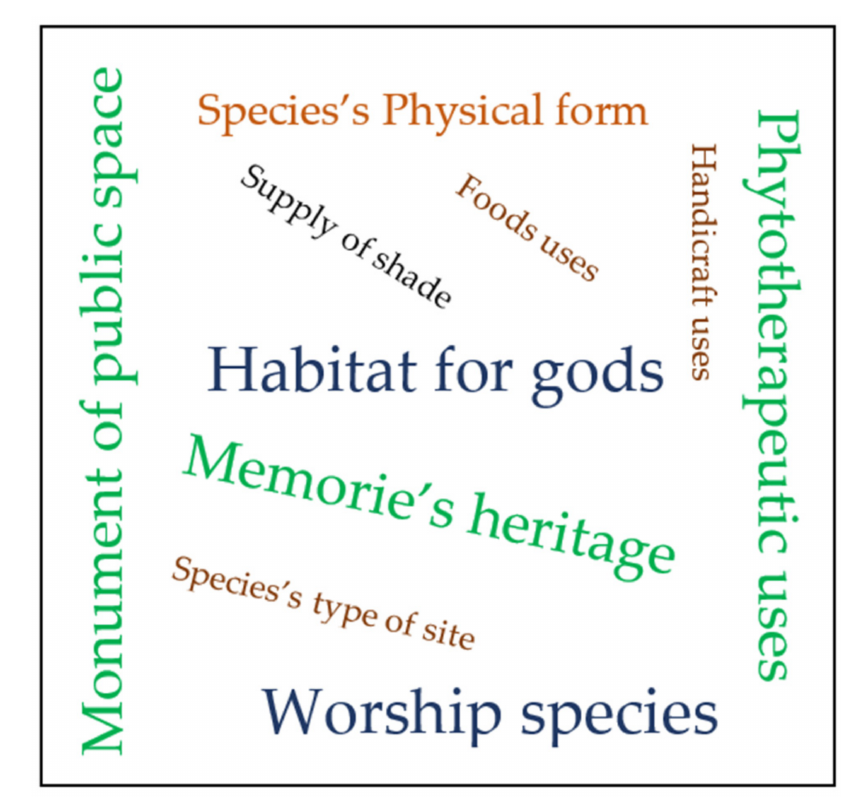
Figure 7. Word cloud of functions and criteria explaining the origin of the local names most reported by people when asked to name LOTs. The size of the words is proportional to the number of times the local name explanation is based on this